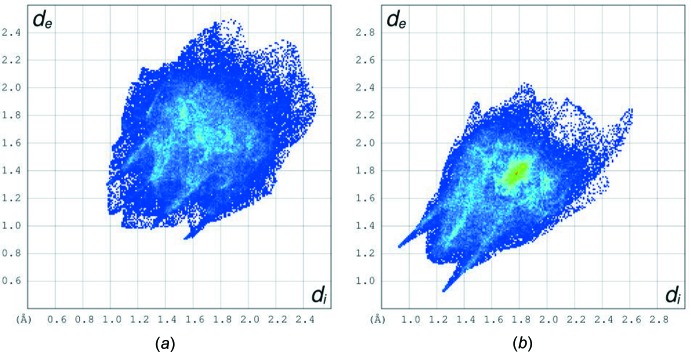
FP plots for (a) [4: R = 3,4,5-(MeO)3C6H2·0.5DMSO] and (b) (4: R = C6H5) in which the blue spikes ending at (1.2; 0.9) and (0.9;1.1) relate to O⋯H/H⋯O contacts and the high intensity of pixels, green and red areas relate to C⋯C contacts.